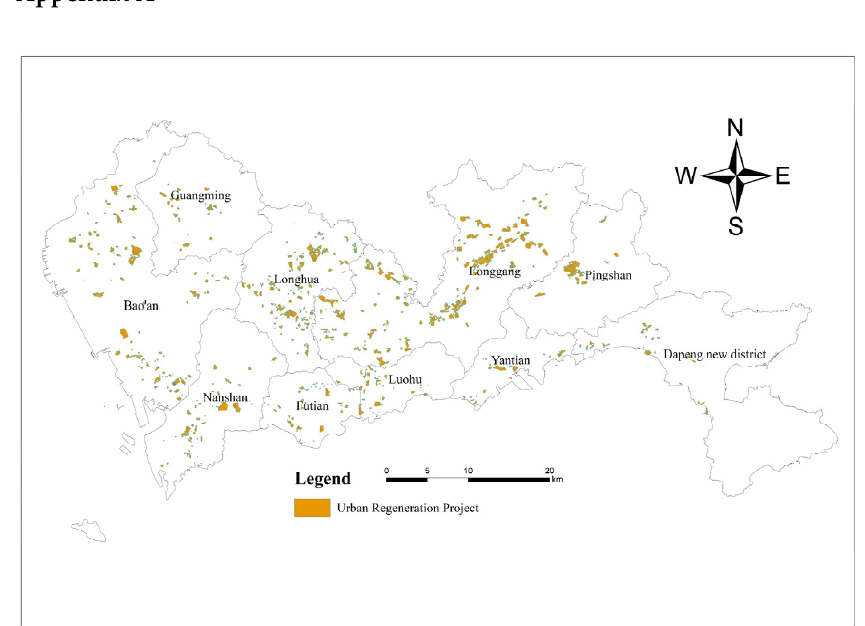
Figure A1. Spatial distribution of UR in Shenzhen.